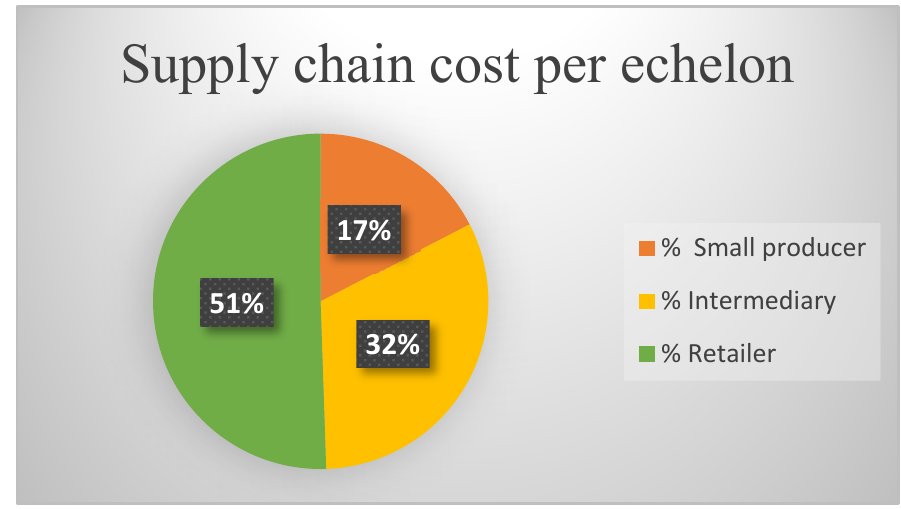
Figure 3. Cost per echelon as a Supply chain total costs percentage. (Source: Authors).